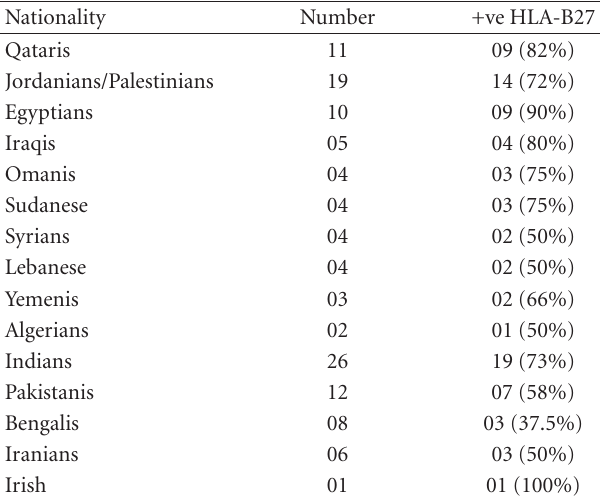
Table 1: HLA-B27 distribution among patients with AS in